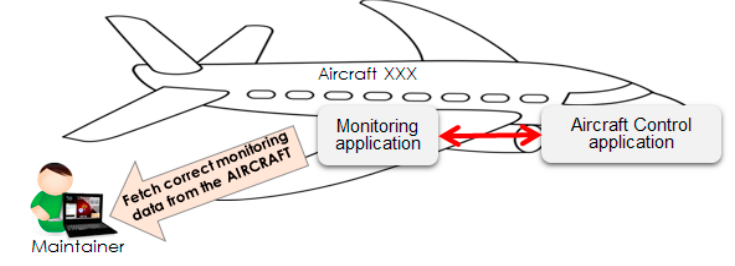
Figure 5. Example scenario